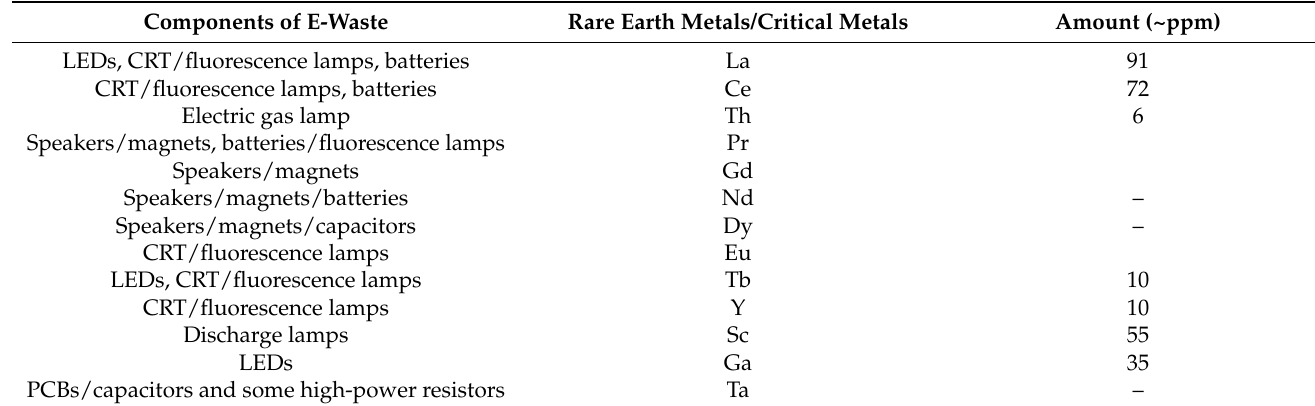
Table 2. Rare earth metals and other critical metals present in various components of